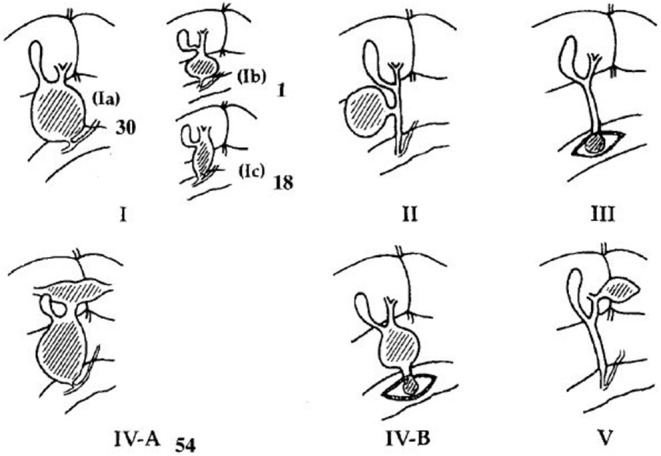
Todani's classification of choledochal cyst.